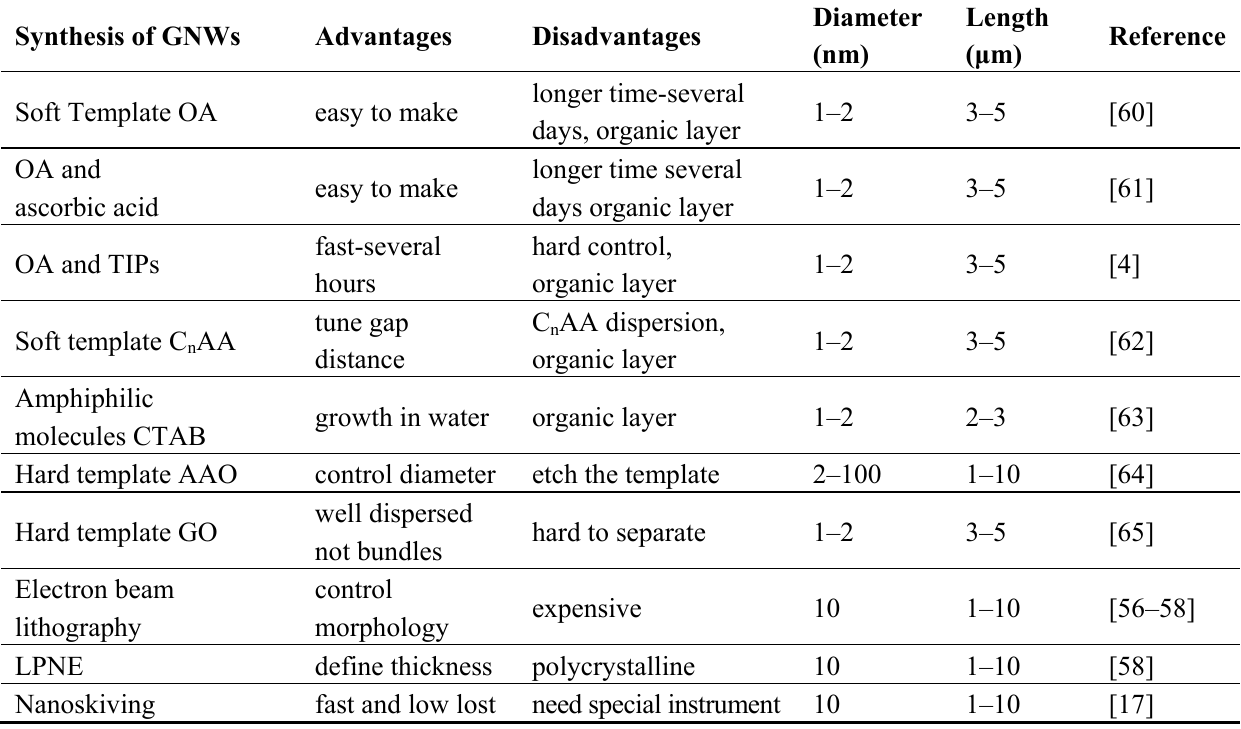
Table 3. List of synthesis methods of gold